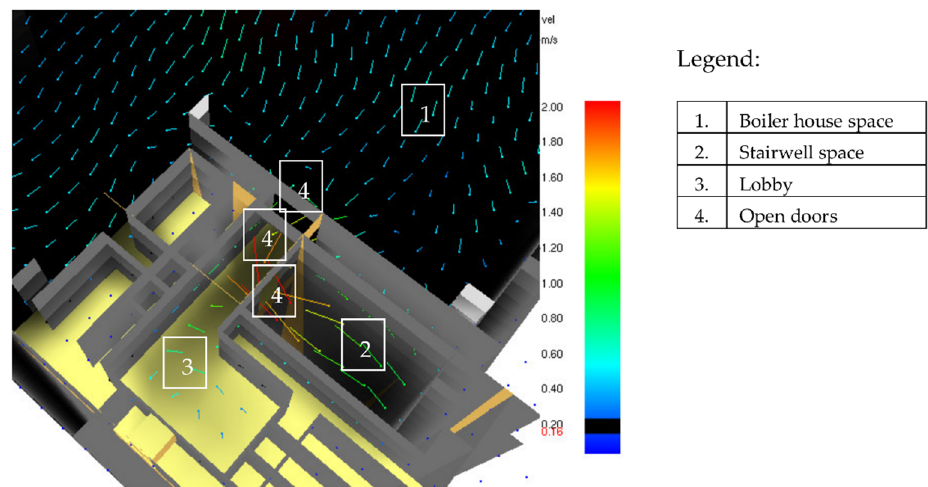
Figure 11. Propagation of smoke in the vestibule and stairwell.